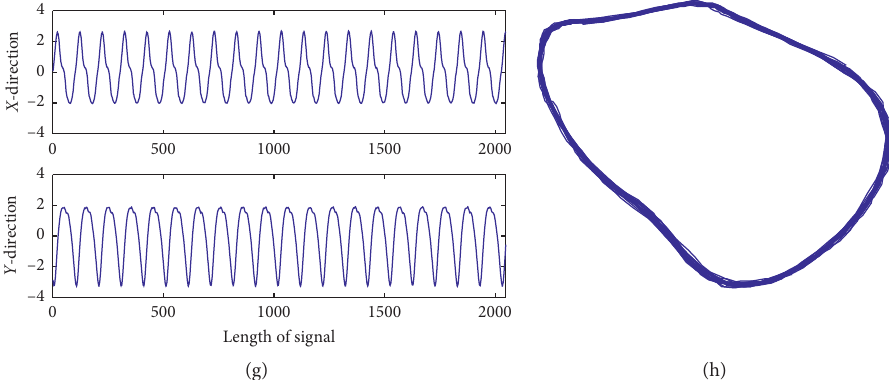
Figure 6: Denoised swing signal and shaft orbit: (a) swing signal of normal state; (b) shaft orbit of normal state; (c) swing signal of unbalanced state; (d) shaft orbit of unbalanced state; (e) swing signal of misaligned state; (f) shaft orbit of misaligned state; (g) swing signal of contact-rubbing state; (h) shaft orbit of contact-rubbing state.